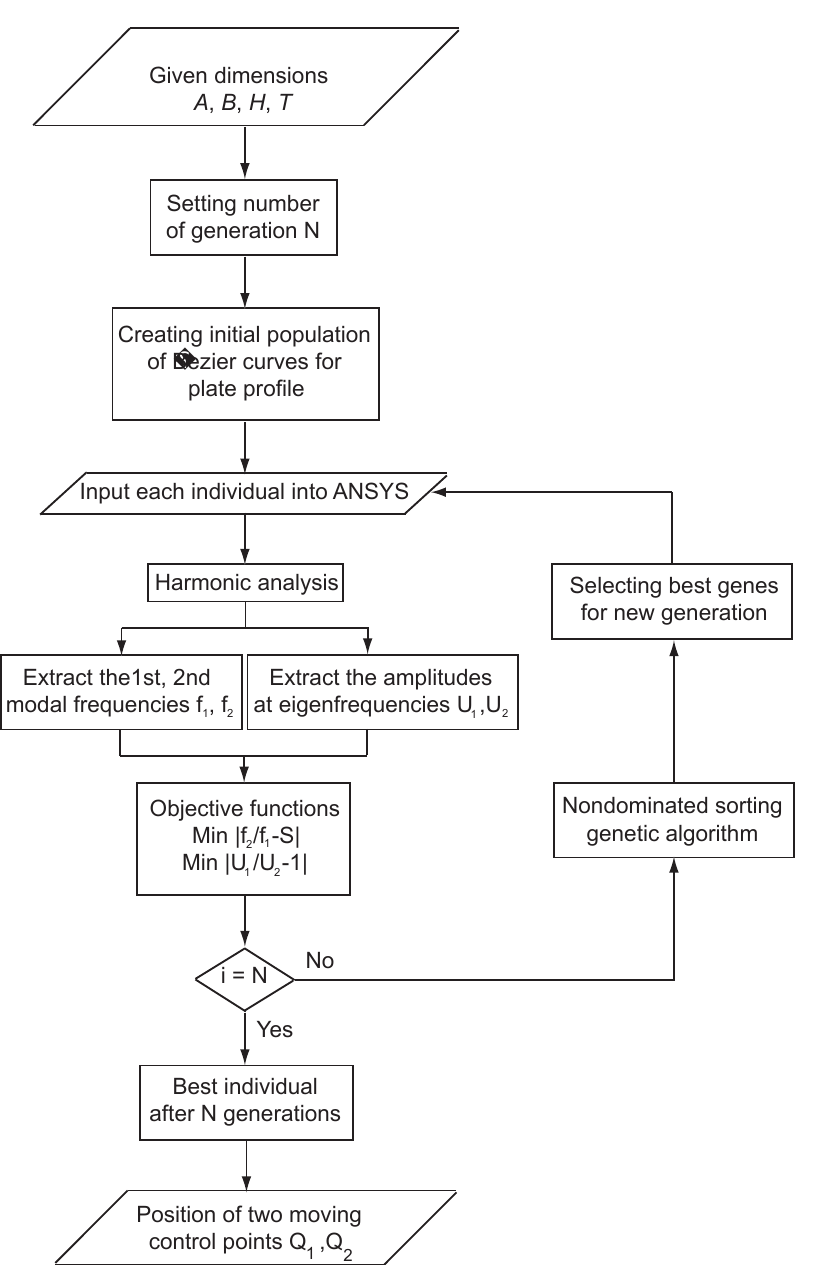
Figure 4. Flowchart of the optimization procedure. Due to the geometric complexity, the modal frequencies, f 1 and f 2 , and the vibration amplitudes, U 1 and U 2 , of the B é zier plate were computed numerically. Finite element analysis using the commercial software ANSYS was utilized to obtain modal frequencies method, Block Lanczos, was used for the modal analysis to find the geometry